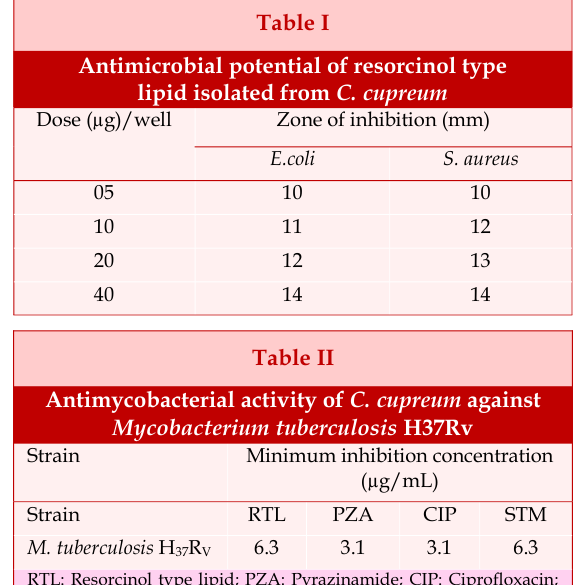
Antimycobacterial activity of C. cupreum against Mycobacterium tuberculosis